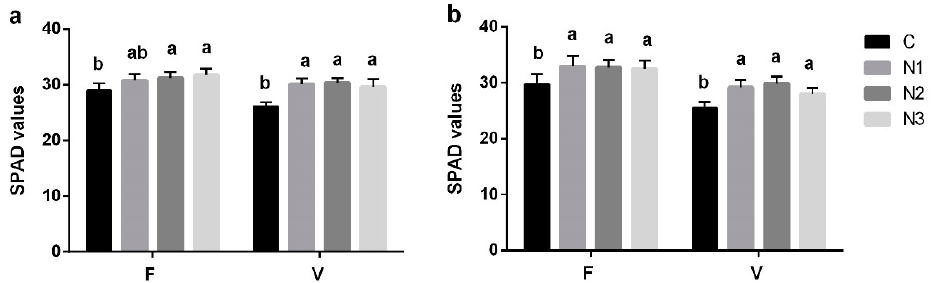
Figure 3. SPAD values recorded at flowering (F) and veraison (V) developmental stages for all treatments in the years 2019 ( a ) and 2020 ( b ). Vertical bars indicate standard errors (SE). Means followed by different letters differ significantly, as calculated using Tukey statistical analysis ( p ≤ 0.05).